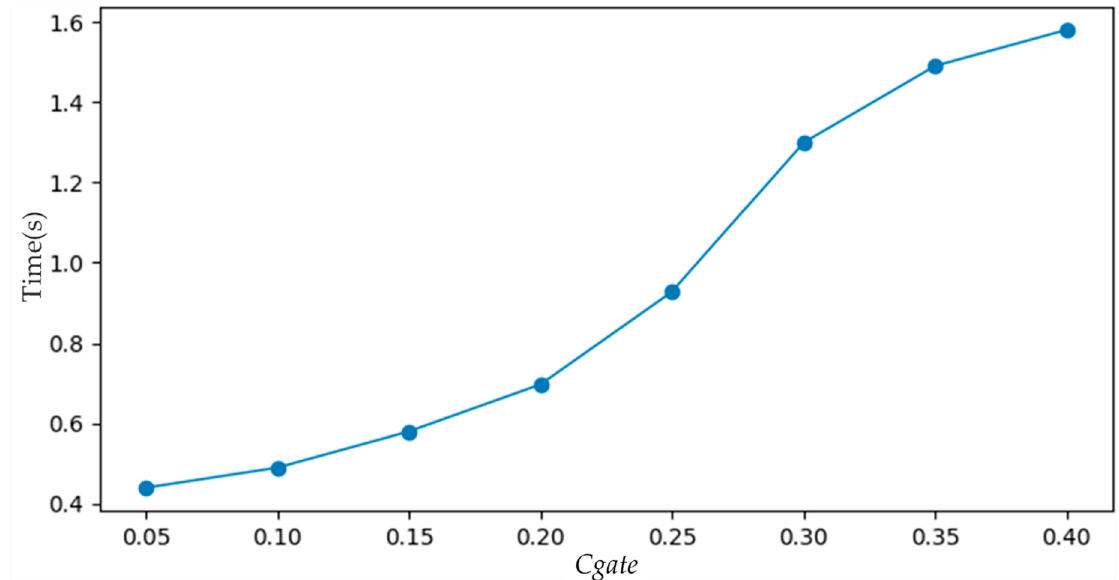
Figure 11. Relationship between average consumed time and Cgate .